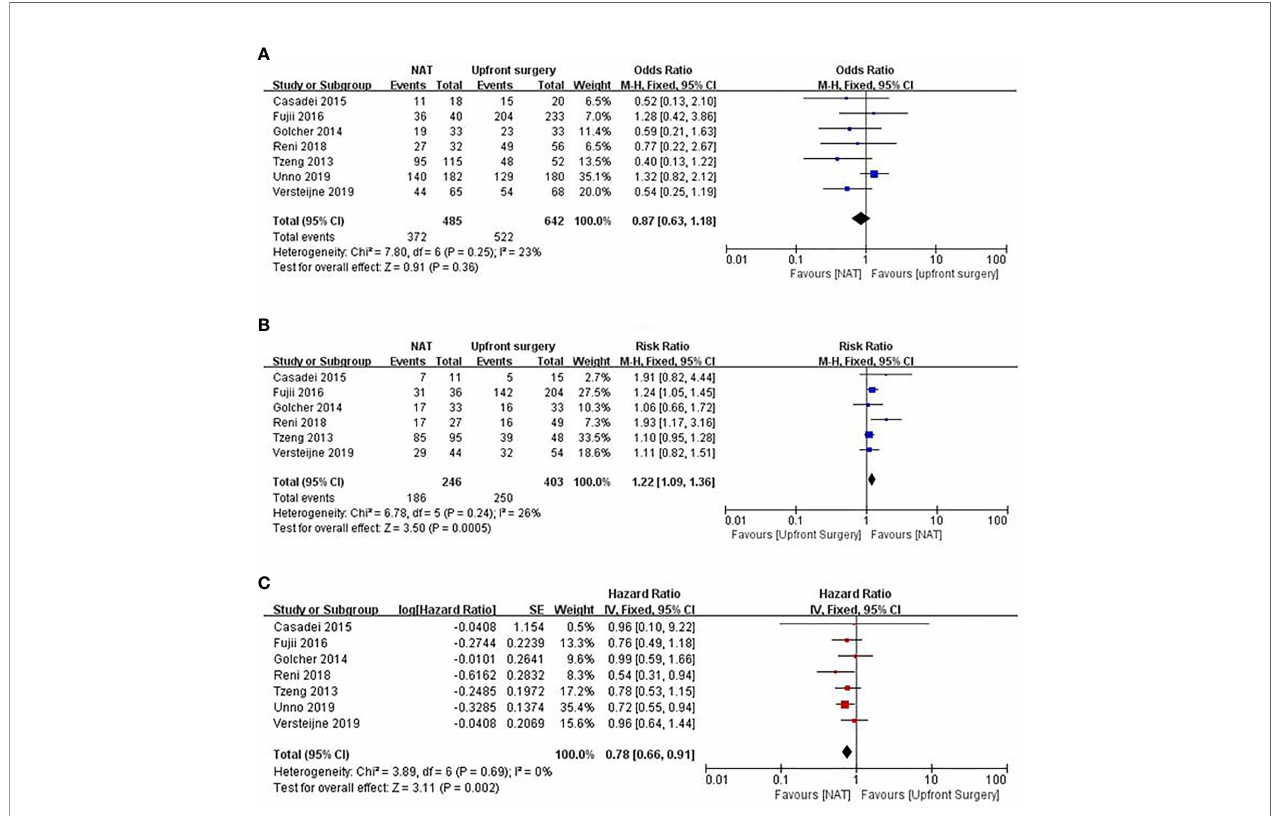
FIGURE 2 | Forest plots showing risk ratios of resection rate (A) , R0 resection rate (B) , and HR of overall survival (C) in